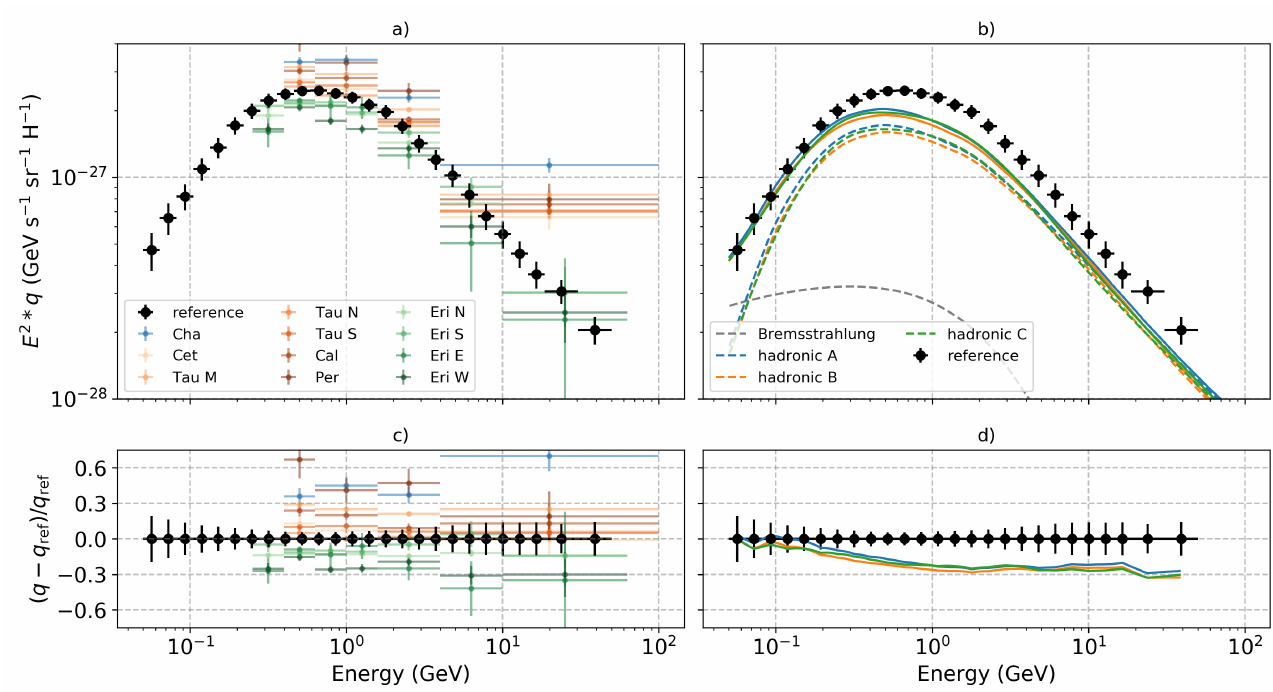
Figure 2. Top panels: gamma-ray emissivity per hydrogen atom in the local interstellar medium. Both panels: reference measurement q ref with the Fermi LAT that provides an average emissivity within a few hundred pc from the solar system [200] (combination of statistical and systematic uncertainties). ( a ) Measurements from a set of individual interstellar clouds (statistical uncertainties only) in Chameleon (blue [201]), Galactic anticentre (orange [202]), and the Orion–Eridanus superbubble (green [203]). ( b ) Calculations of the emissivity based on direct CR measurements for different choices of the H and He CR spectra, and of the hadronic gamma-ray production models: model A is based on CR nuclei spectra from [212] and hadronic production models from [128] and [123]; model B on CR nuclei spectra from [213] and the same hadronic production models as in model A; model C is based on the same CR nuclei spectra as in model A and on the hadronic production models from [123] and [129]. In all models Bremsstrahlung is calculated based on the electron and positron LIS by [97] and on the cross-section formulae by [214]. Hadronic emission is shown by the dashed lines, while the total including electron Bremsstrahlung is shown by the solid lines. See the text for more details on the models. Bottom panels: relative deviation of all measurements ( c ) and models ( d ) with respect to q ref